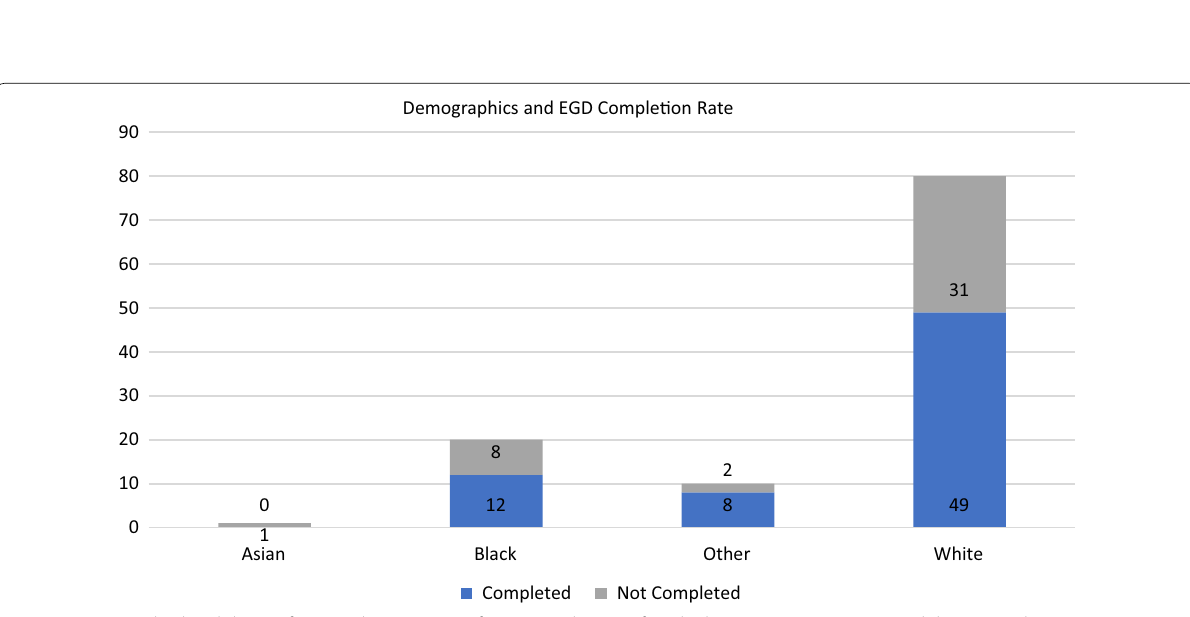
Fig. 3 Demographic breakdown of race and percentage of EGD completion. Of studied participants 1 was Asian (did not complete screening), 20 were black (12, or 60%, completed screening), 10 were other (8, or 80%, completed screening) and 80 were white (49, or 61.3%, completed screening). There was no significant difference found between race and rate of screening completion (Additional file 2)